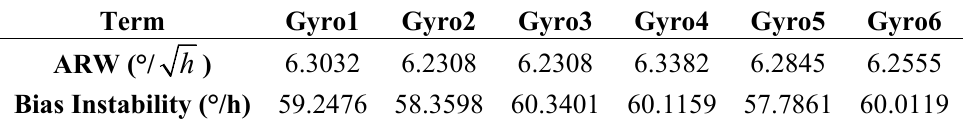
Table 3. Allan variance analyses of component gyroscopes for noise parameters of angular random walk (ARW) and bias instability with associated 90% confidence